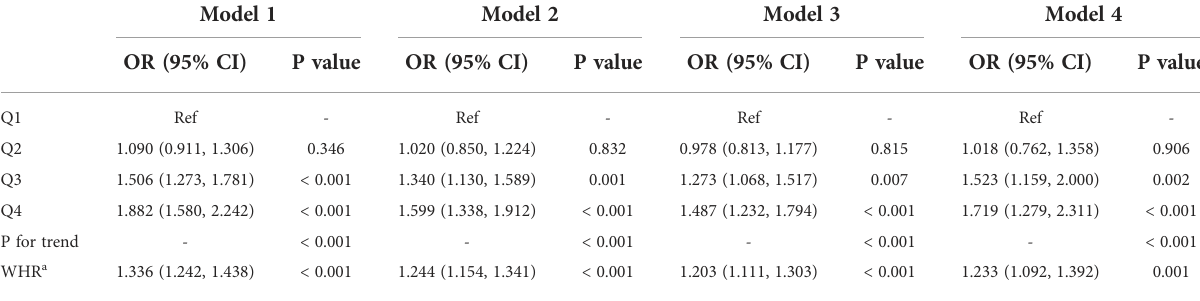
TABLE 2 Multivariate logistic regression analysis of factors associated with the SC-MI.